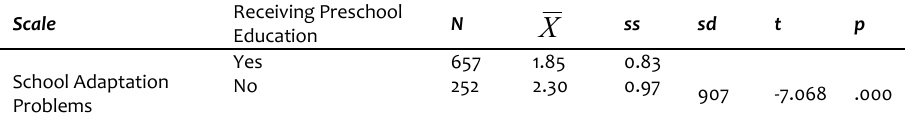
Table 6. T Test Results Concerning Primary School Students' School Adaptation